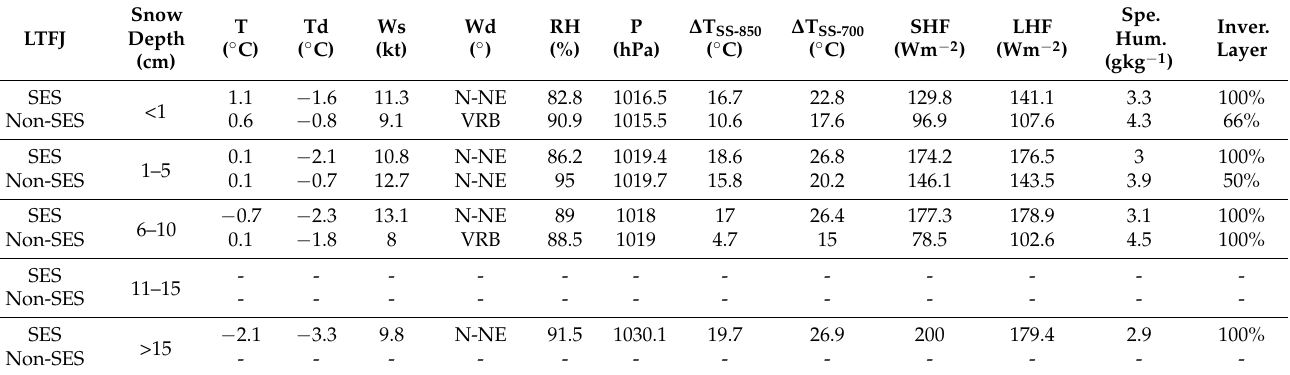
Table 6. Average values of meteorological parameters in SES and non-SES events according to snow depth intervals at